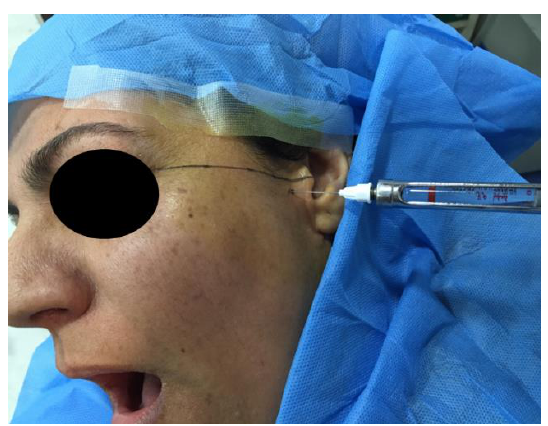
Figure 4: Illustrates injection of local anesthesia in